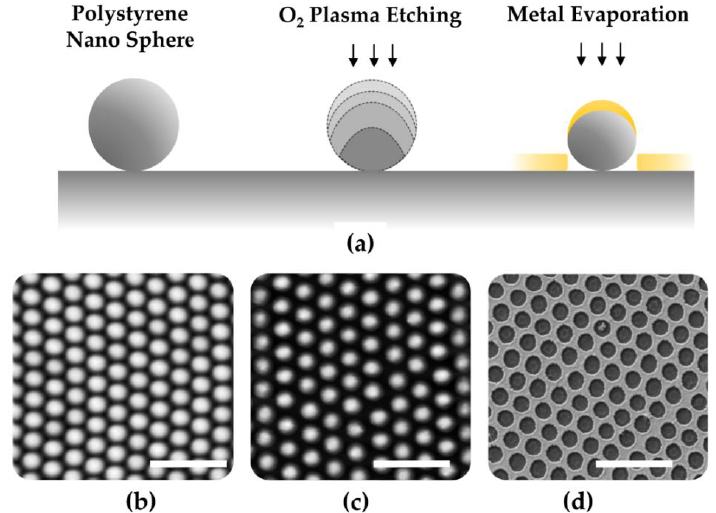
Figure 1. ( a ) Schematic illustration of the self-assembly at an air/water interface. The water surface is used as a medium to facilitate the self-assembly, then a peristaltic pump is used to slowly remove the water and transfer the ordered close packed array (CPA) monolayer onto a solid substrate located on the bottom of the trough. ( b ) Sketch of the multistep colloidal lithography protocol implemented to fabricate short-range ordered NH arrangements. Left panel: distributions of polystyrene nanospheres self-assembled electrostatically onto a collector PDDA monolayer. Middle panel: removal of the gold-capped colloids by tape stripping. Right panel: supported gold film perforated with short-range ordered nanoholes (NHs).